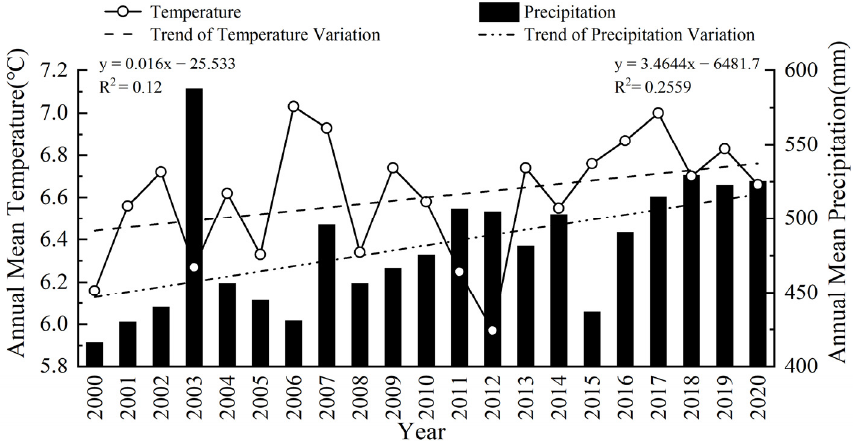
Figure 6. The trends of annual precipitation and average annual